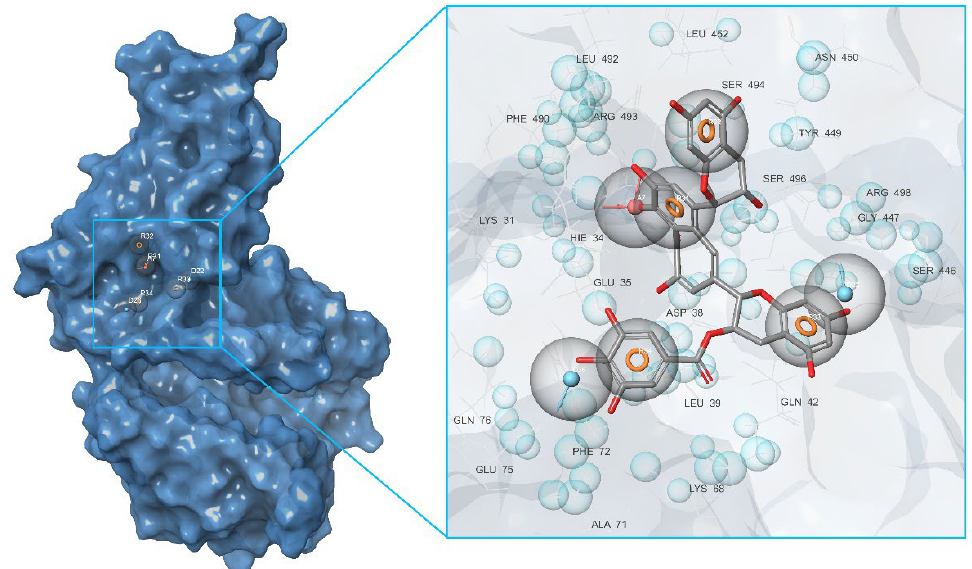
Figure 4. Pharmacophore model of the RBD site b of spike protein generated by the Receptor-ligand method.